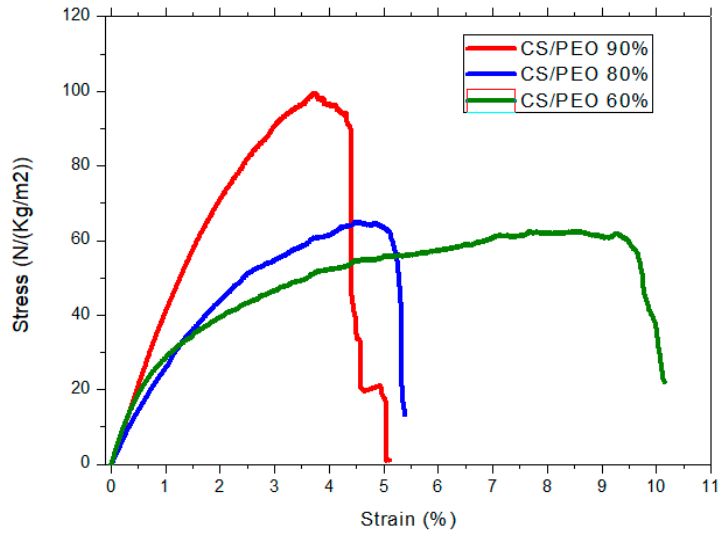
Figure 2. Uniaxial extension for as-spun CS/PEO nanofibers obtained from different composition blends. CS MW = 160 kg/mol and PEO MW = 5000 kg/mol.